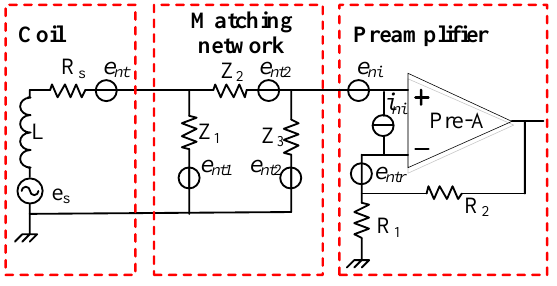
Figure 10. The proposed CSMN circuits with equivalent noise sources.